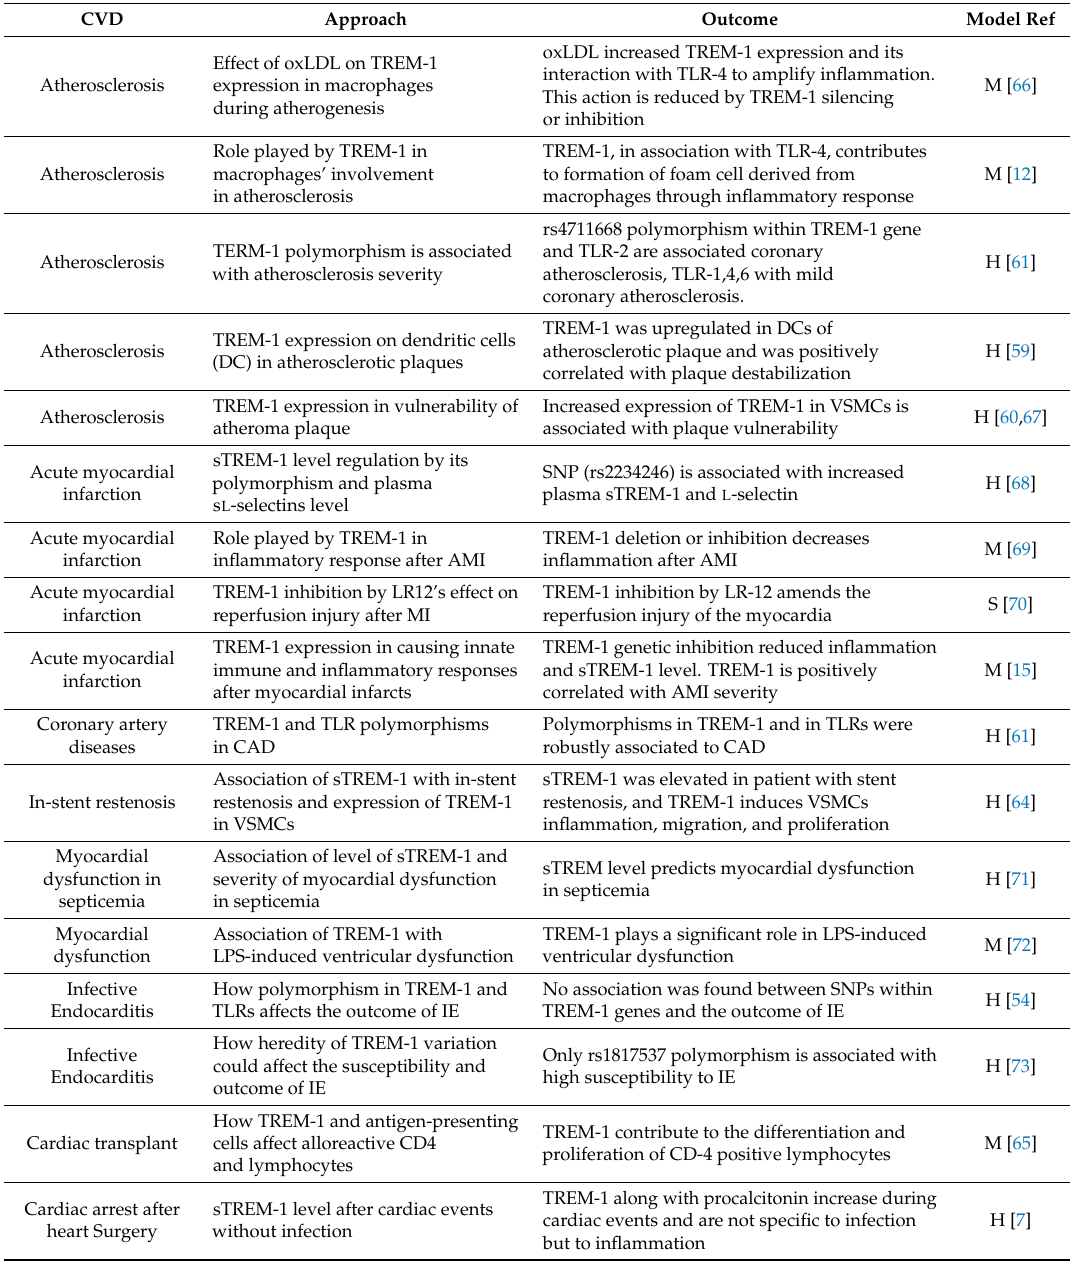
Table 1. Involvement of TREM-1 in cardiovascular